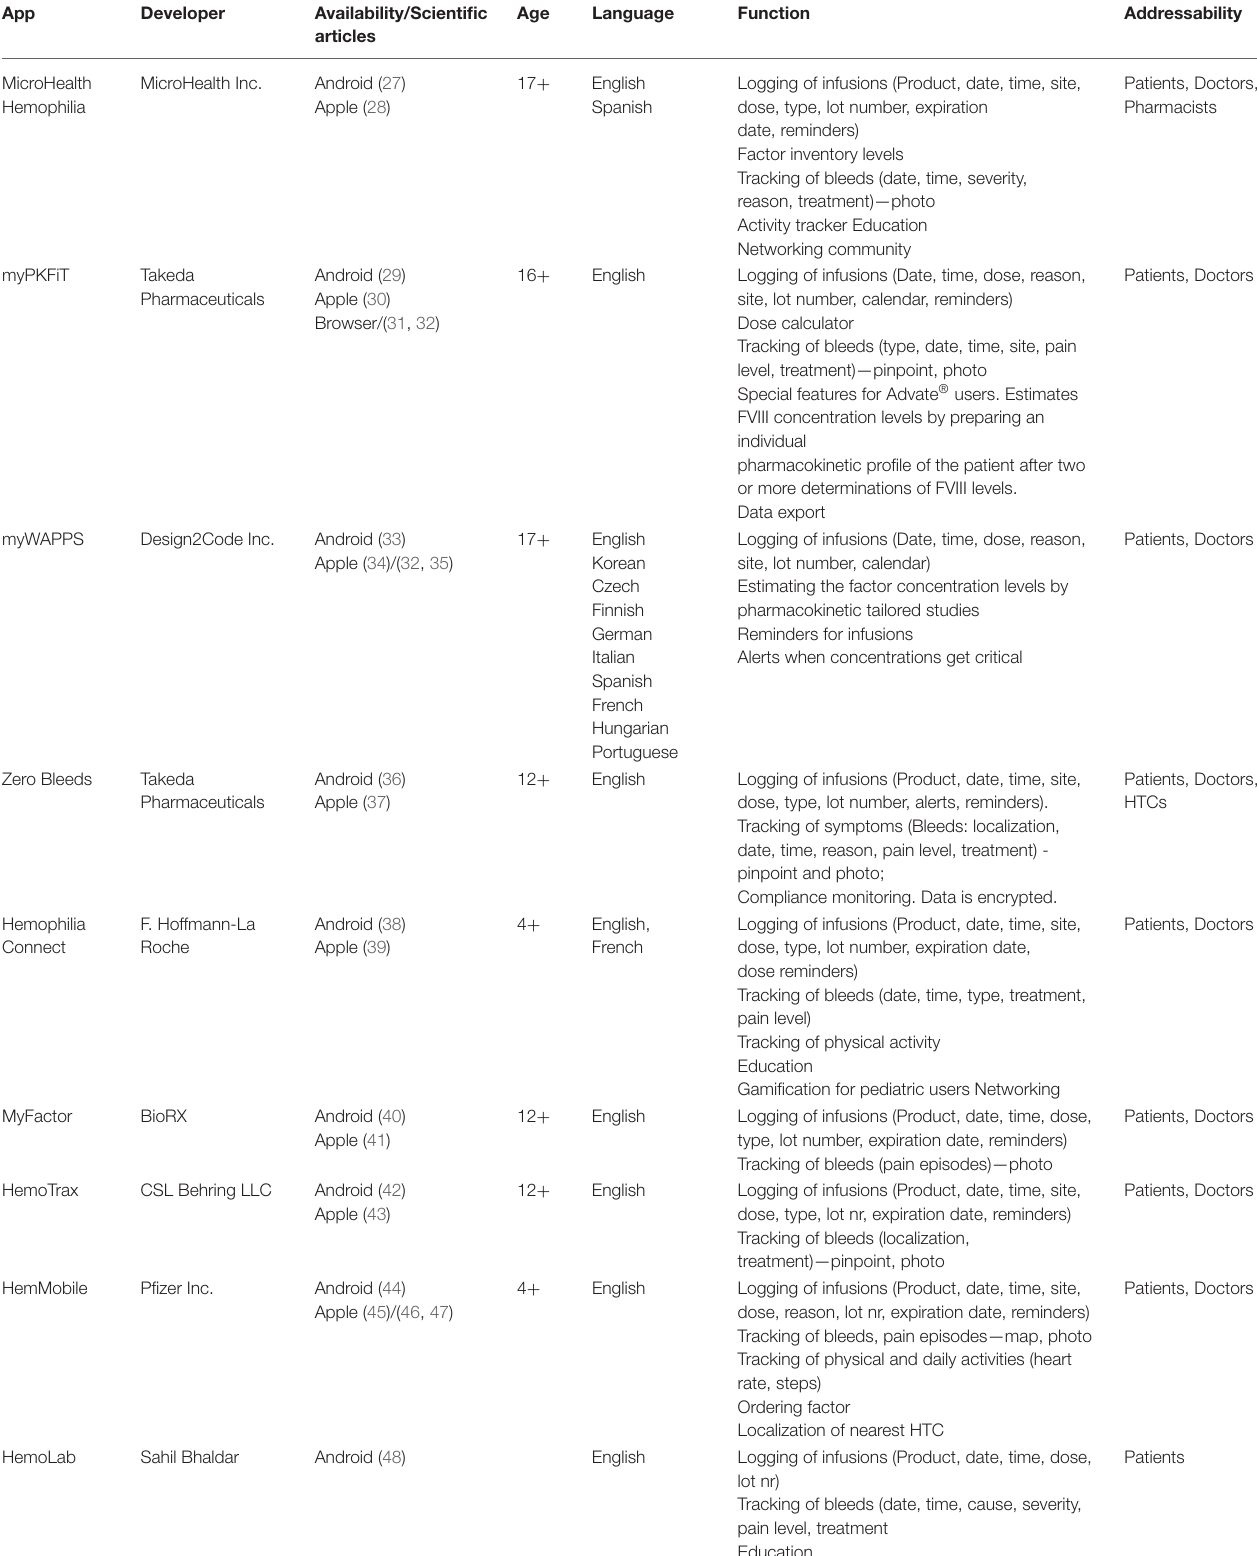
TABLE 1 | mHealth technologies for hemophilia